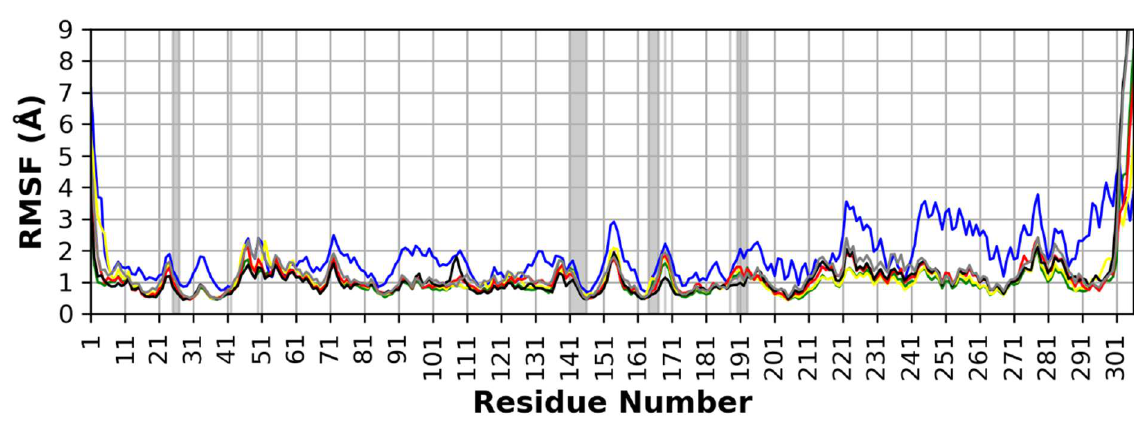
Figure 3. Per residue, RMSF for the protein residues in the six MD runs. (Green: complex 1 (ferulic acid), blue: complex 2 (rutin), yellow: complex 3 (gallic acid), red: complex 4 (chlorogenic acid), black: complex 5 (co-crystallized N3), gray: complex 6 (docked N3)). The binding site amino acids are highlighted with a grey background.